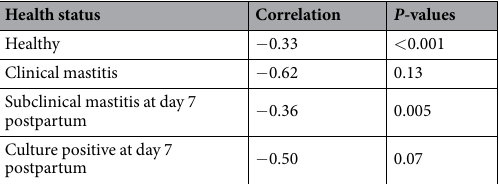
Table 1. Correlation between Shannon diversity index and bacterial load in mammary gland health status. The bacterial load was measured via proxy of the number of 16S rRNA genes.